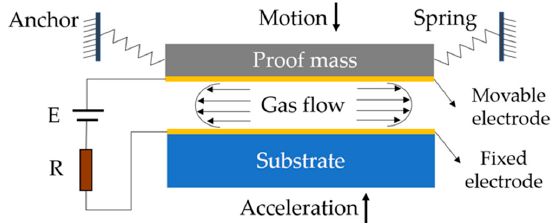
Figure 1. Basic model of a conventional inertial micro-switch.